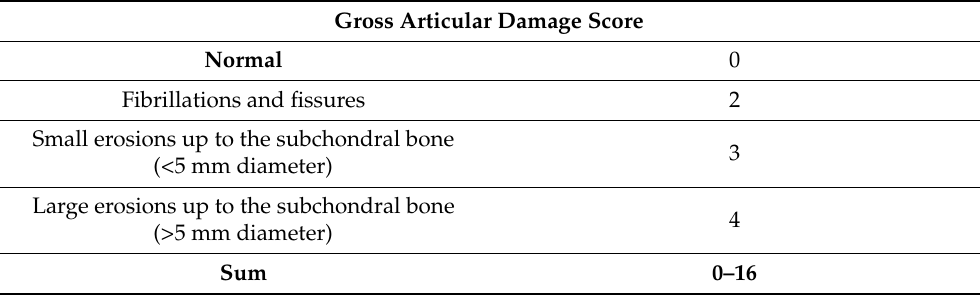
Table 1. Gross articular damage score, assessed in the central cartilage of the medial and lateral tibial condyles, medial and lateral femoral condyles (4 quadrants). Each total score is the sum of the score of each quadrant. Minimum = 0; maximum =